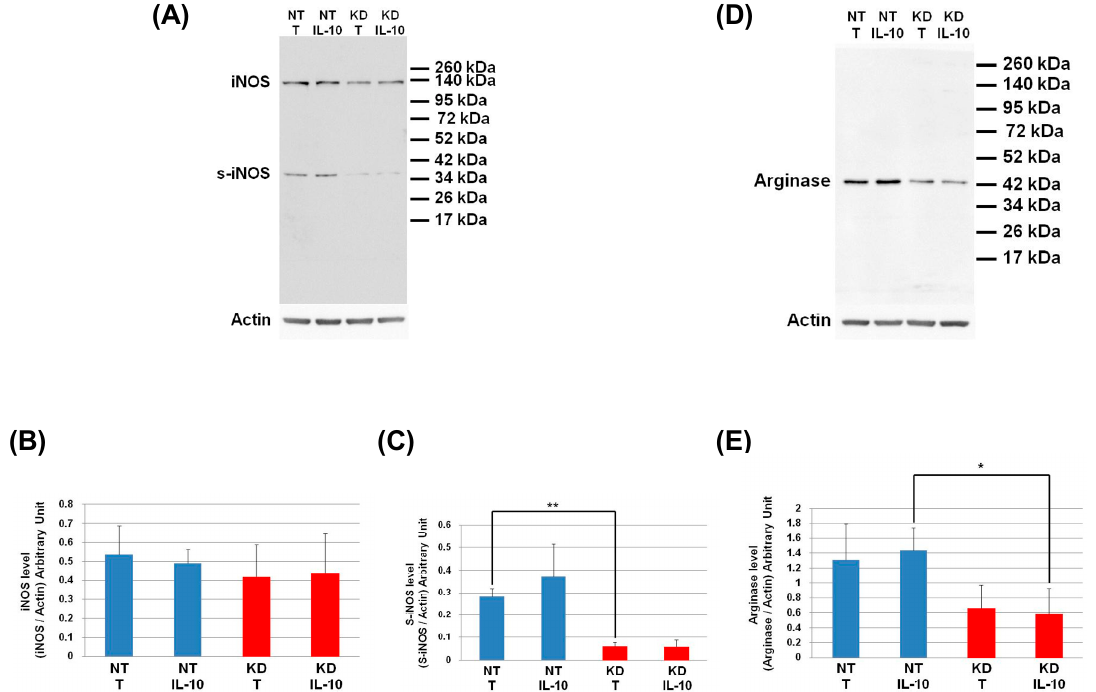
Figure 9. Under IL-10 treatment, PC1 / 3 KD cells exhibit lower levels of arginase than NT cells. NT and PC1 / 3 KD NR8383 macrophages were treated with 20 ng / mL of IL-10 for 24 h. ( A ) Western blot studies conducted with anti-iNOS. ( B ) Intensities of iNOS quantified and normalized to those of Actin. ( C ) Intensities of s-iNOS quantified and normalized to those of Actin. ( D ) Western blot studies conducted with anti-arginase. ( E ) Intensities of arginase quantified and normalized to those of Actin. The results are obtained from three independent experiments and depicted through graphic representations (means ± SD). Data are analyzed by the Student t -test and values of p < 0.05 are considered statistically significant (* p -value of < 0.05, ** p -value of < 0.01).